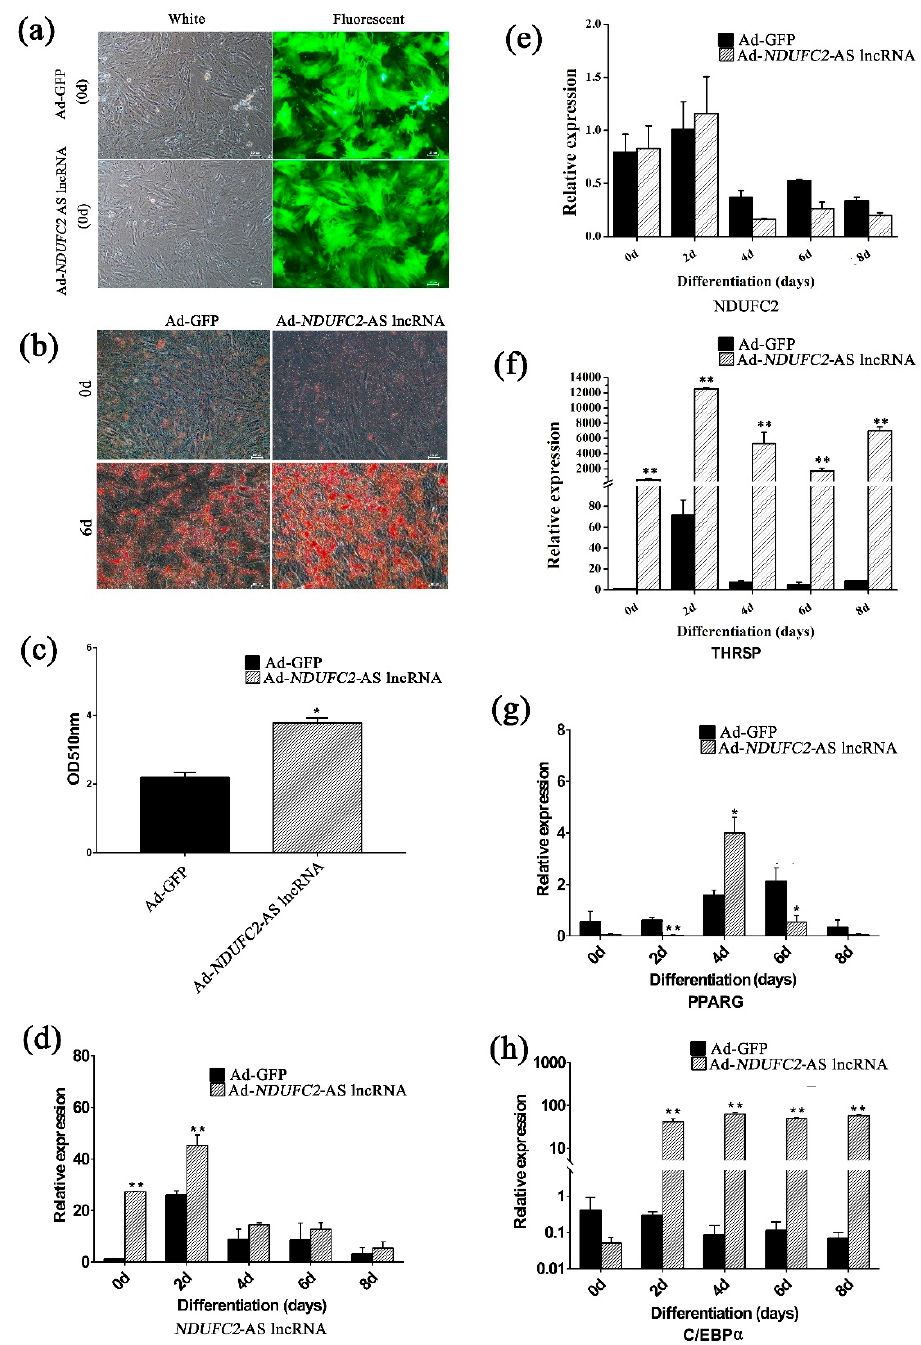
Figure 5. Overexpression of NDUFC2 -AS lncRNA promotes lipid accumulation in bu ff alo primary adipocytes. ( a ) Micrographs of GFP-positive bovine adipocytes under white and fluorescent light in the Ad-GFP (control) and NDUFC2 -AS lncRNA groups. Adipocytes were induced to di ff erentiation 2 days after adenovirus transduction. 0d represents the time of di ff erentiation. Scale bar, 100 µ m. ( b ) Images of Oil Red O staining in bu ff alo adipocytes transfected with Ad-GFP and Ad- NDUFC2 -AS lncRNA at day 0 and day 6 of adipogenic di ff erentiation. Scale bar, 100 µ m. ( c ) Histogram showing the quantitation of Oil Red O staining by spectrophotometry (normalized to control group). ( d – h ) The RNA expression dynamics of NDUFC2 -AS lncRNA, NDUFC2 , THRSP , PPARG , and C / EBP α during adipogenic di ff erentiation in bu ff alo adipocytes transfected with Ad-GFP and Ad- NDUFC2 -AS lncRNA. Comparison was analyzed by Student’s t test or nonparametric test. Data are presented as mean ± SD ( n = 3, *, p < 0.05, **, p <